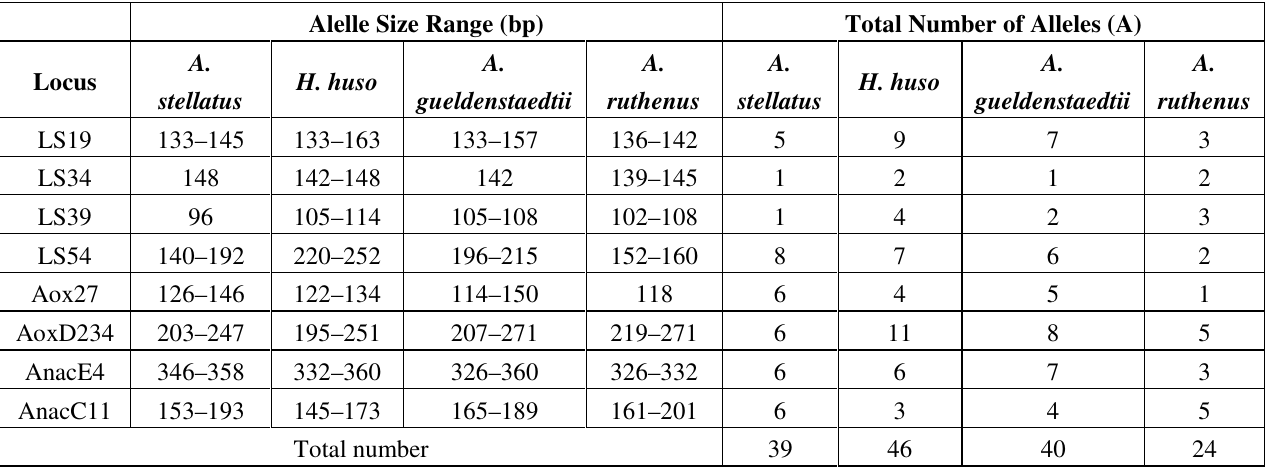
Table 1. Characteristics of eight microsatellite loci selected for hybrids diagnostic. Alelle Size Range (bp) Total Number of Alleles (A)